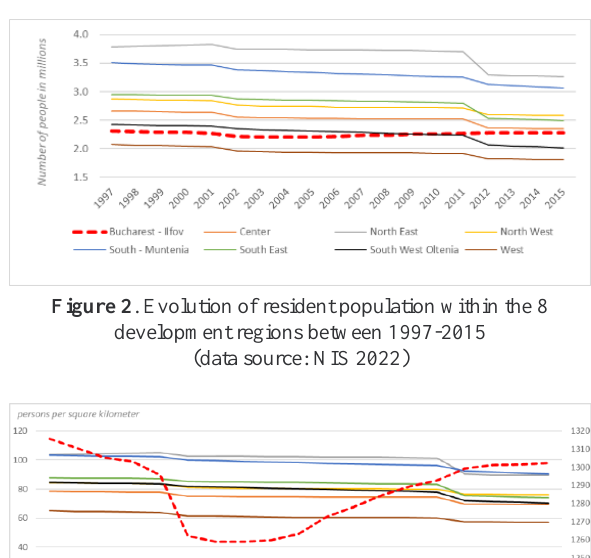
Figure 1 . Overall urban expansion of Bucharest and Ilfov County between 1985 and 2015 (data source: WSF Evolution, DLR, CC-BY 4.0; base map: © OpenStreetMap contributors)